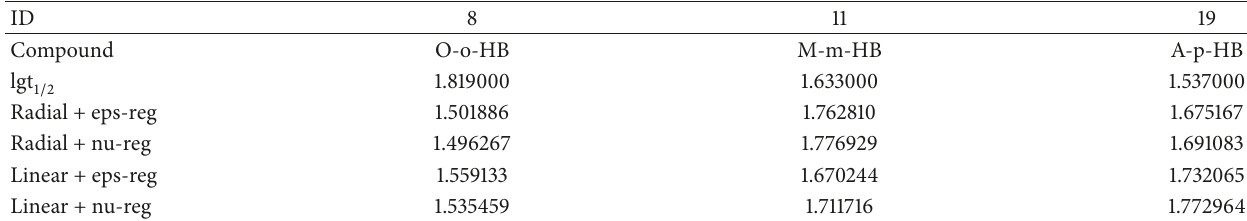
Table 7: Experimental values and prediction results of test set of lgt 1/2 .